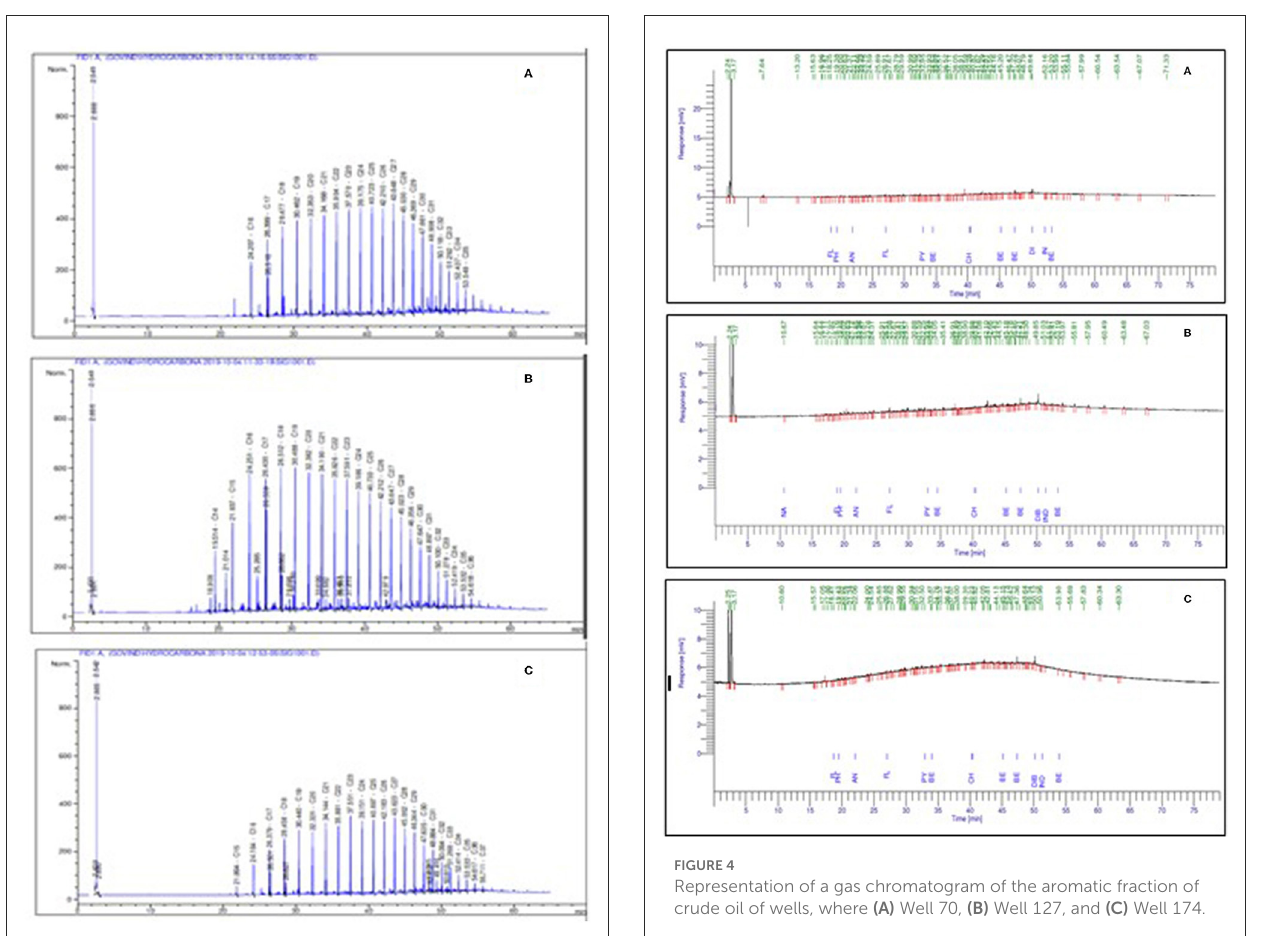
FIGURE3 Representation of the gas chromatogram of an aliphatic fraction of crude oil of wells, where (A) Well 70, (B) Well 127, and (C) Well 174.